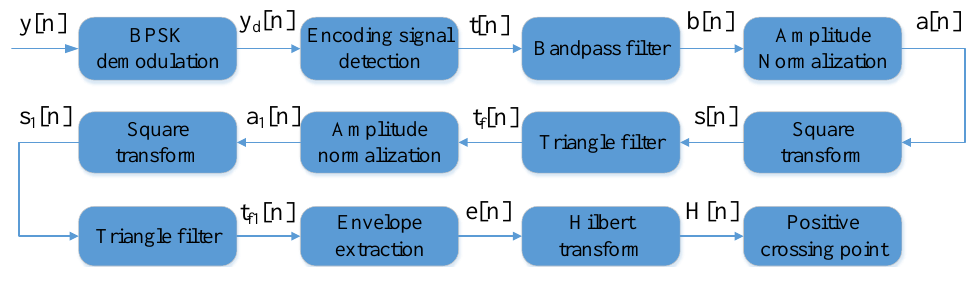
Figure 12. Peak detection algorithm flow.